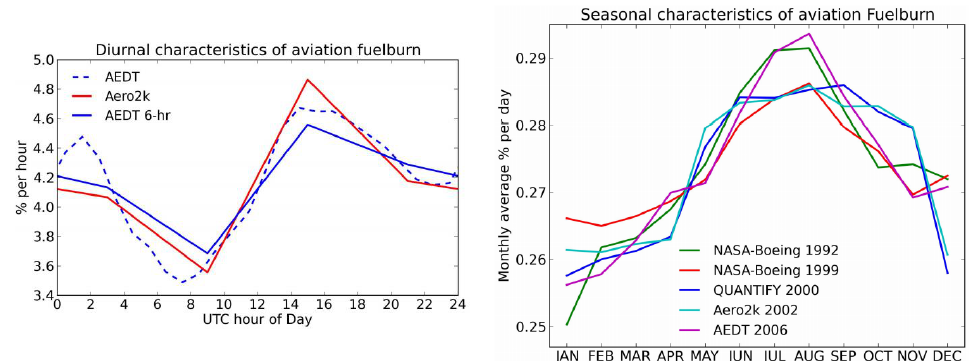
Figure 8. Temporal (diurnal and seasonal) distribution of global aviation fuel burn expressed as percentage from a range of aircraft emissions datasets. Figure obtained from Olsen et al. [77] licensed under CC BY